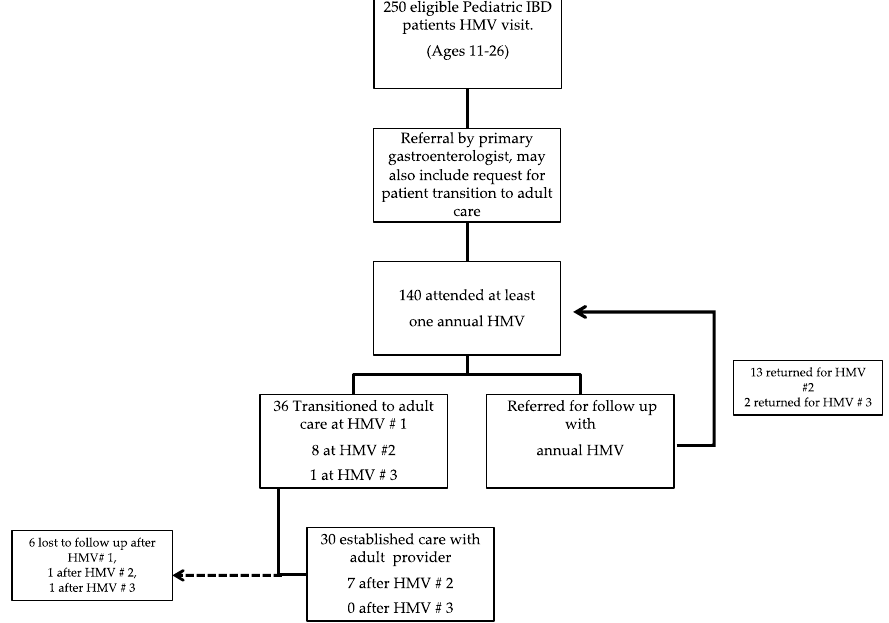
Figure 1. Patient Flow through Health Maintenance visits (HMV) and Transition of Care visits. IBD: inflammatory bowel disease. Number of HMV visits completed indicated by # followed by numeral.